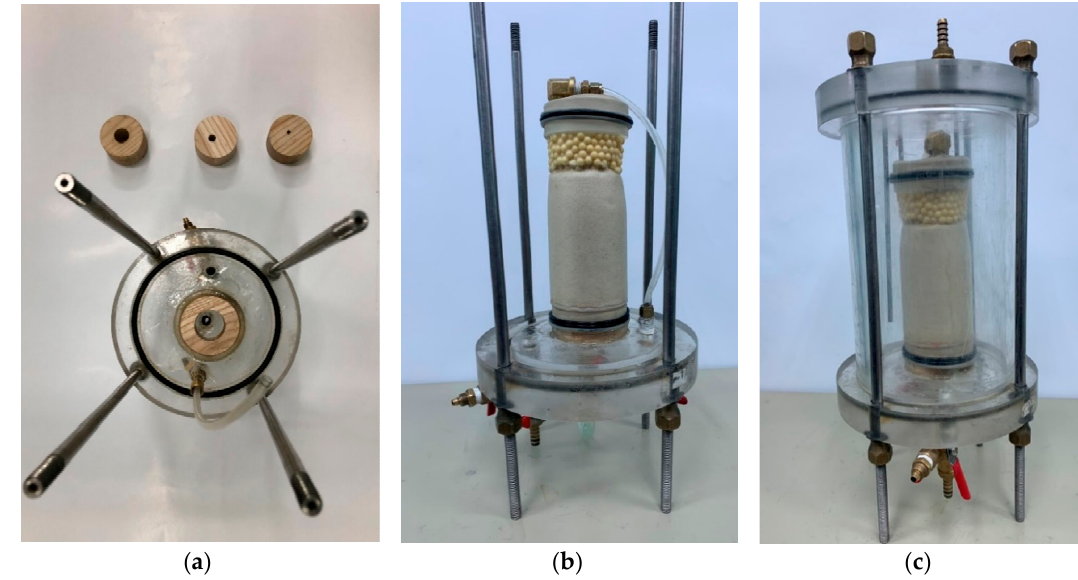
Figure 3. Assembly of the specimen cell: ( a ) seepage exit opening in wooden plug; ( b ) specimen under vacuum; ( c ) complete specimen cell.